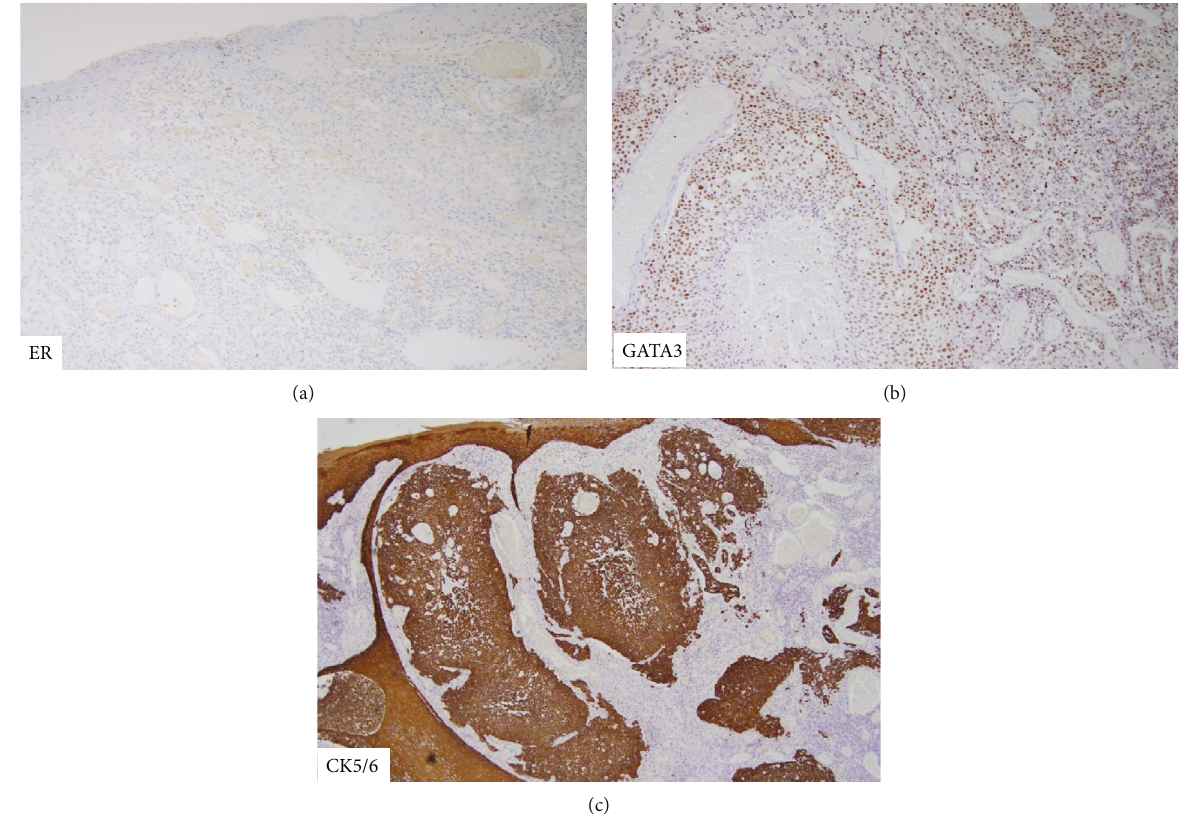
Figure 4: Immunohistochemistry analysis results: (a) ER (-); (b) GATA 3 (+); (c) CK5/6 (+). Table 1: General characteristics, EPC histopathological and immunohistochemical features, treatment modalities, and outcomes in terms of response or